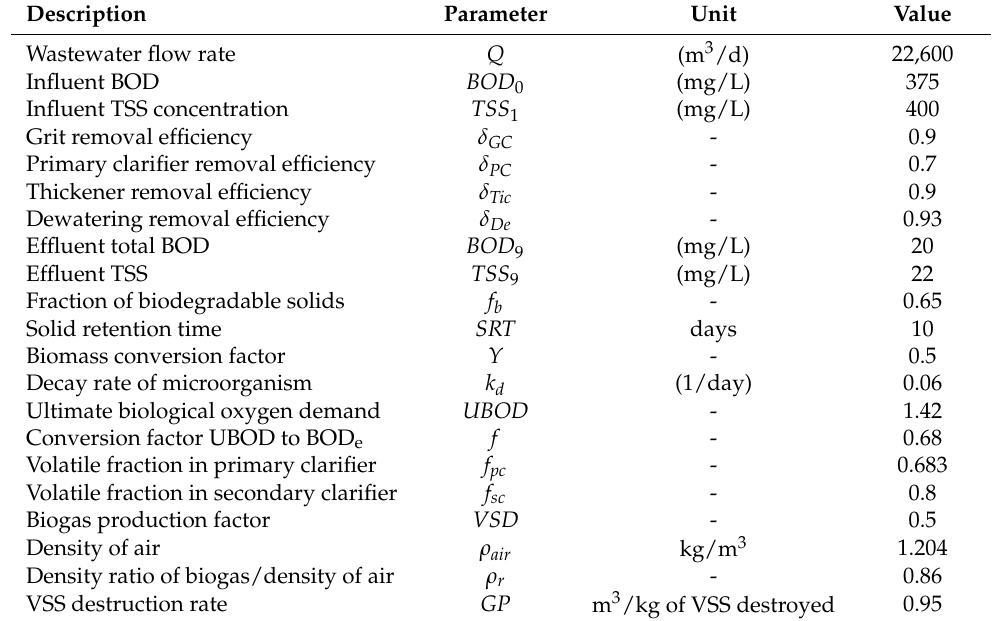
Table 1. WWTP modeling assumptions